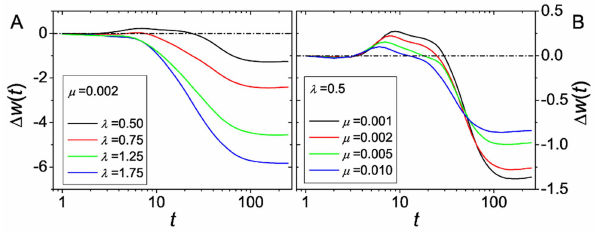
Figure 4. Advantage of recombination for infinite populations. The figures show the results of simulations in the infinite population size limit. (A) shows a comparison for different choices of l and (B) a comparison for different mutation rates m